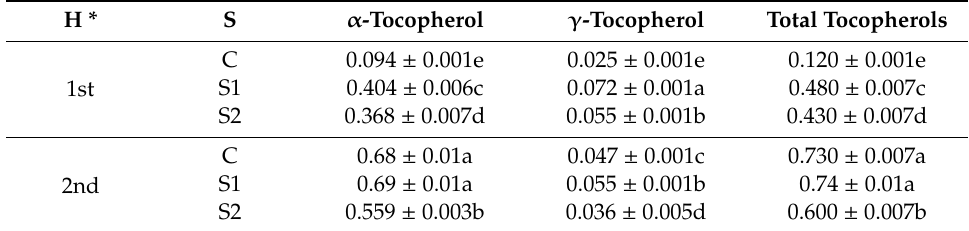
Table 3. Composition in tocopherols (mg / 100 g fw) of Centaurea raphanina subsp. mixta leaves in relation to harvesting time (H) and salinity level (S) (mean ± SD, n = 3). H * S α -Tocopherol γ -Tocopherol Total